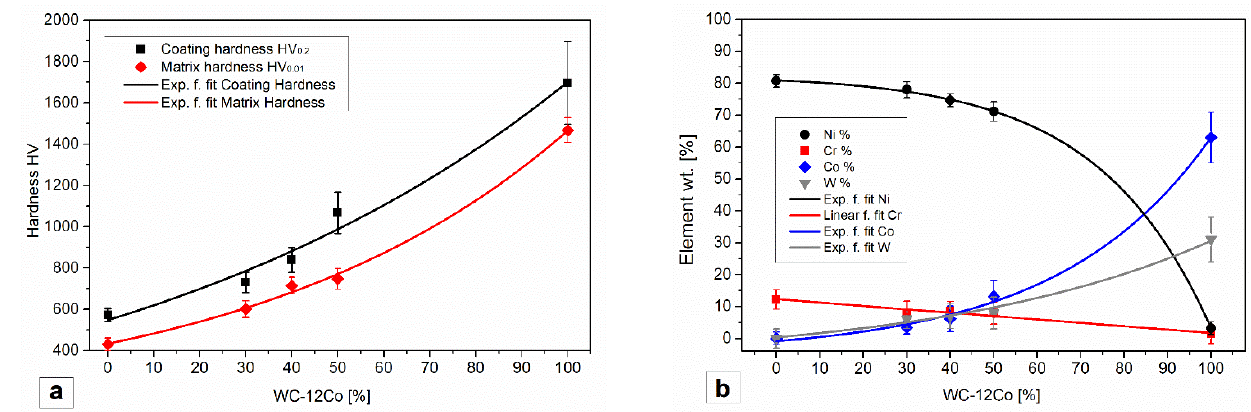
Figure 6. ( a ) Influence of WC-12Co content on the coating and matrix hardness and ( b ) variation of the main alloying elements.